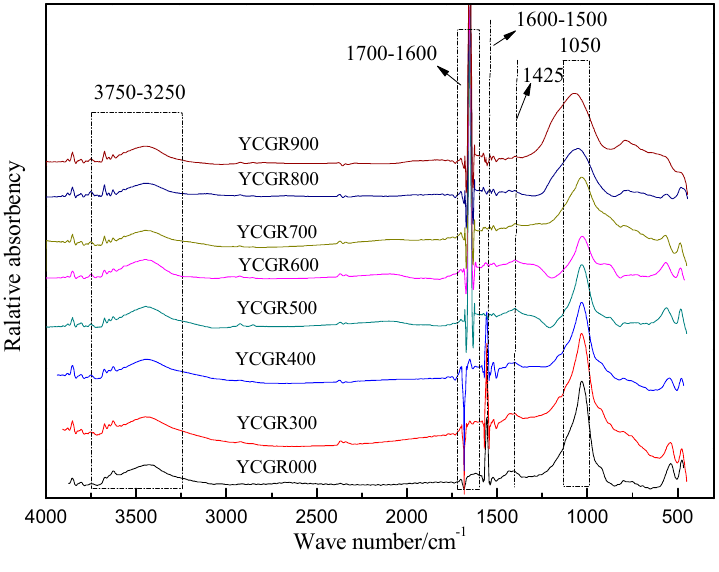
Figure 2. Fourier transform infrared (FTIR) spectra of raw coal and char samples obtained from pyrolysis at different temperatures at a fast heating rate.